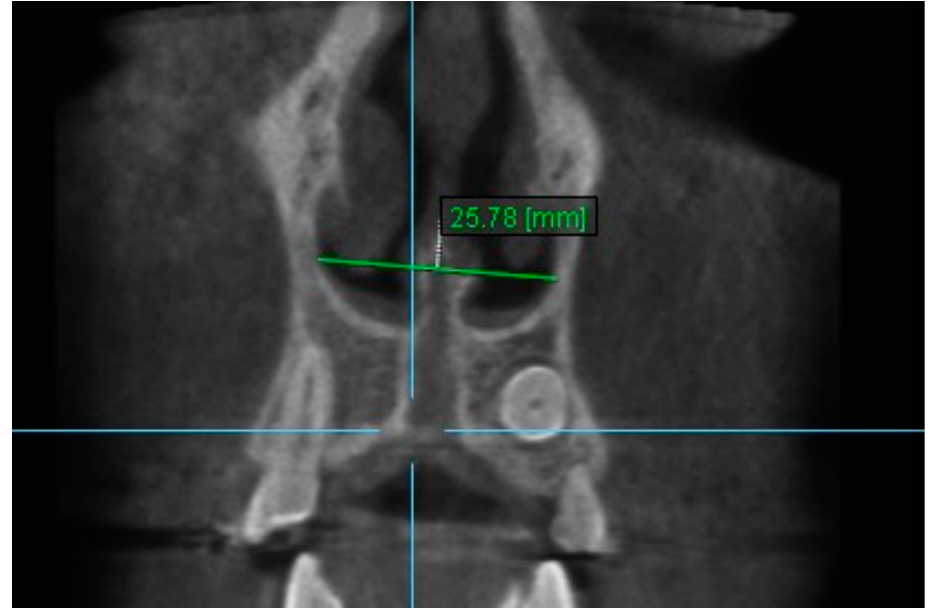
Figure 8. Nasal Width 6.